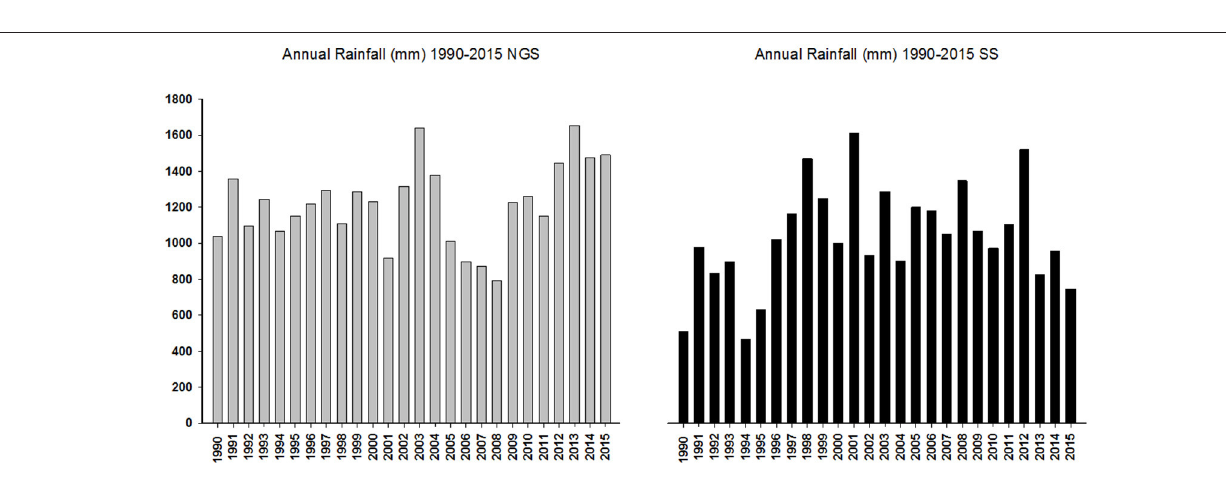
FIGURE 2 | Twenty six years (1990–2015) total annual rainfall for Northern Guinea (Zaria) and Sudan Savanna